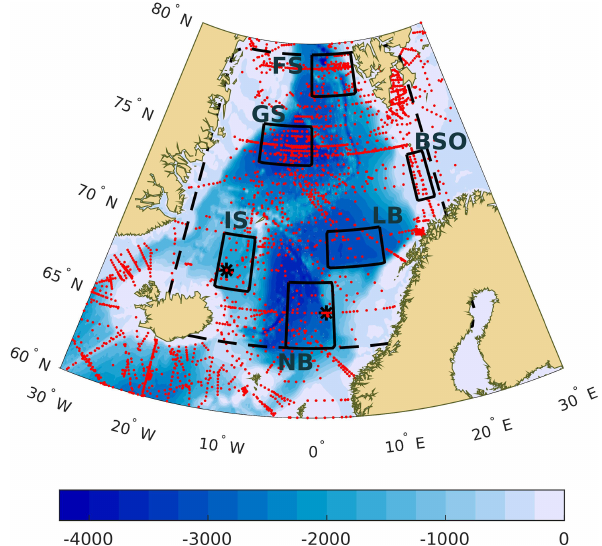
Figure 1. Map of the Nordic Seas with sampling locations (red). Also shown are the locations of the six regions where trends have been analyzed separately (rectangles), that is BSO (Barents Sea Opening), FS (eastern Fram Strait), GS (Greenland Sea), IS (Iceland Sea), LB (Lofoten Basin), and NB (Norwegian Basin). The dashed line marks the borders of the area that we define as the Nordic Seas. The asterisk markers in the Norwegian Basin and the Iceland Sea show the positions of Ocean Weather Station M and the Iceland Sea time series station, respectively. The filled contours illustrate the bathymetry at 250m